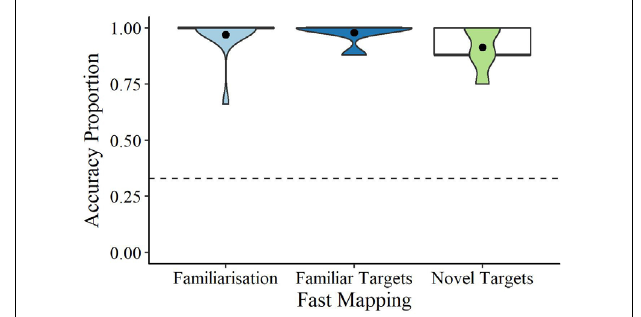
FIGURE 3 | Violin and boxplots of accuracy scores for familiarization, and familiar and novel target fast mapping trails. Dots denote the means, bold lines the medians, and the dashed line chance (0.33).